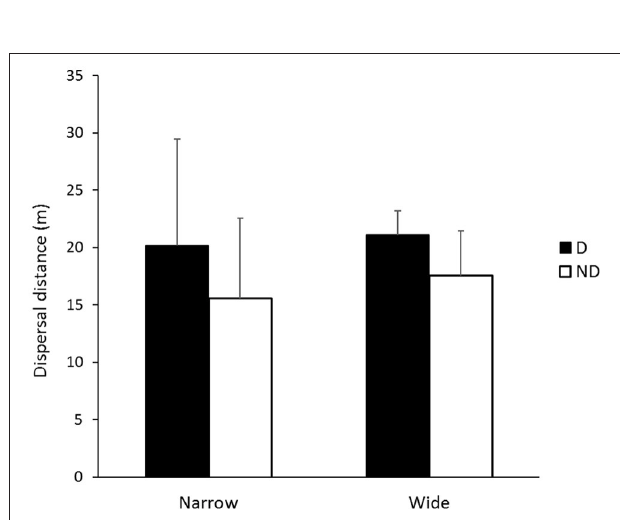
FIGURE 3 | Mean dispersal distances (m) for Iridomyrmex purpureus in disturbed (D; n = 352) and non-disturbed (ND; n = 252) zones in narrow and wide roadside environments. Error bars represent standard error of the